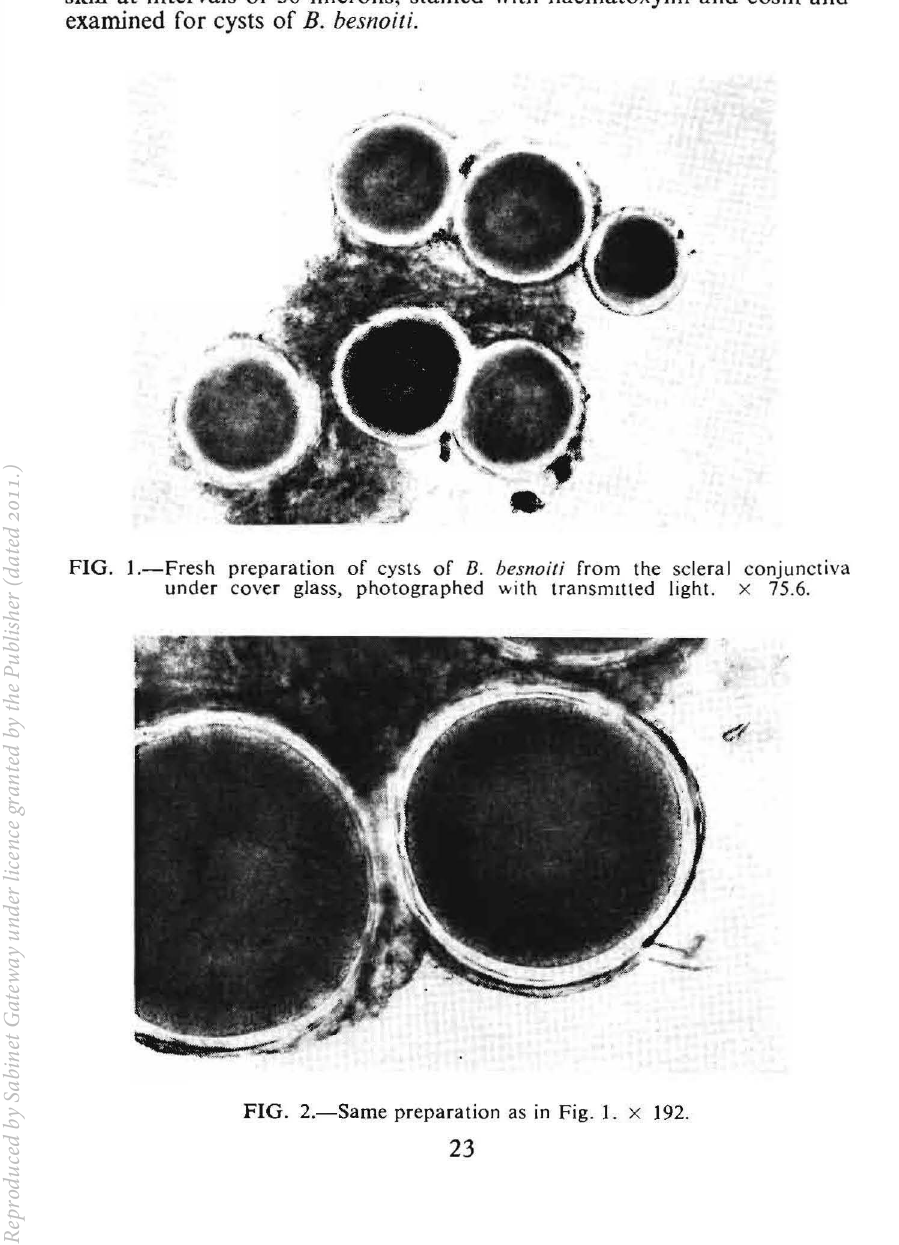
FIG. 2.-Same preparation as in Fig. I. x